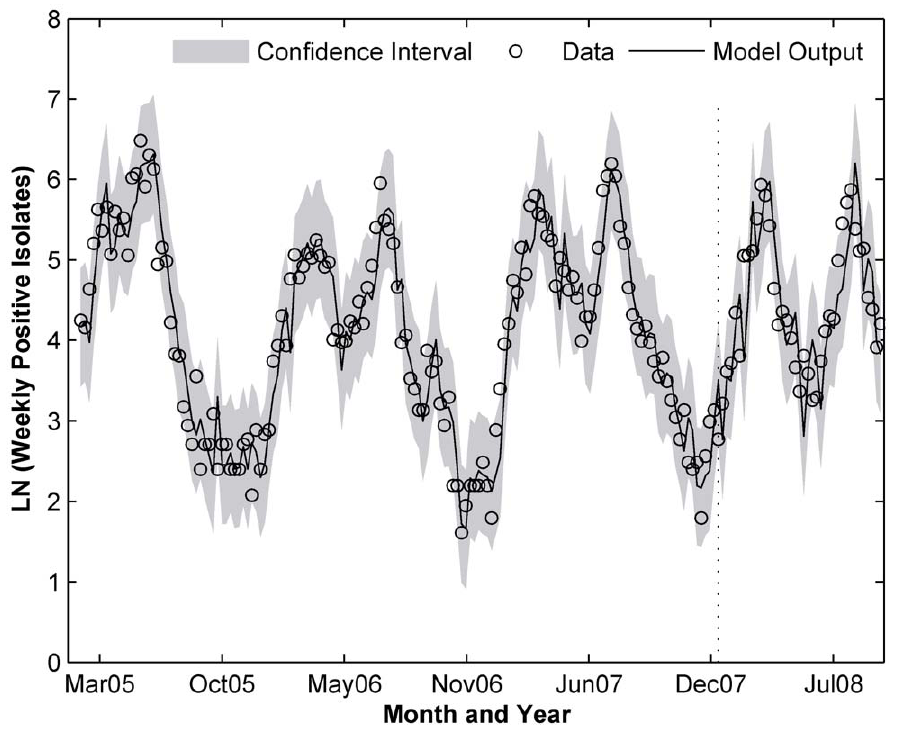
Figure 2. Hong Kong fitted and predicted values as separated by the dashed line. SARIMAX(0,1,2)(1,0,0) with LST lag 2 and 5, accumulated rainfall lag 3 and relative humidity lag 1.